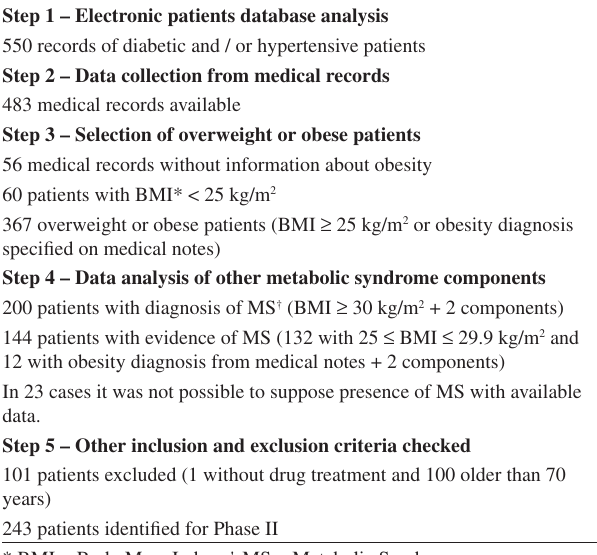
Table 1 - Results of each step of medical record analysis